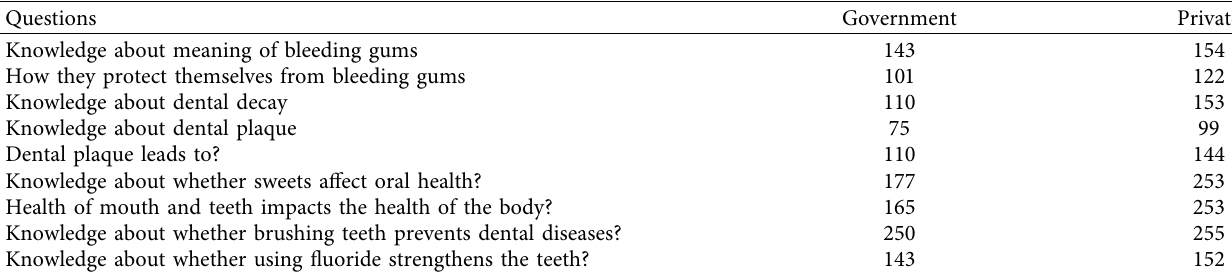
Table 7: Comparison of oral health knowledge among government and private school teachers on the basis of right responses.